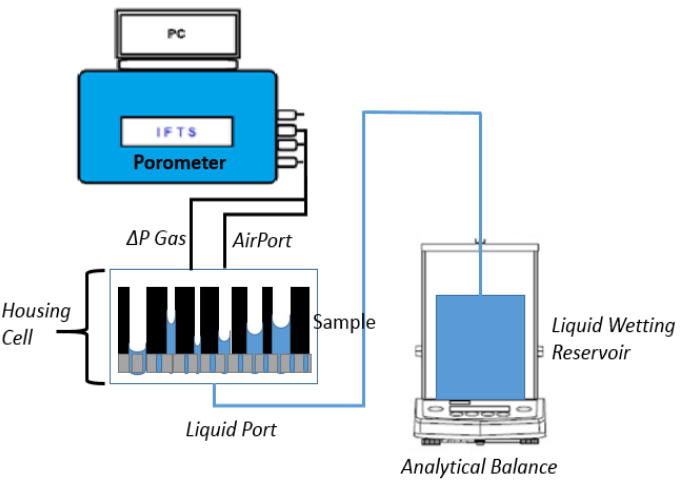
Figure 2. Schematic diagram of Liquid Extrusion Porometer. System setup.